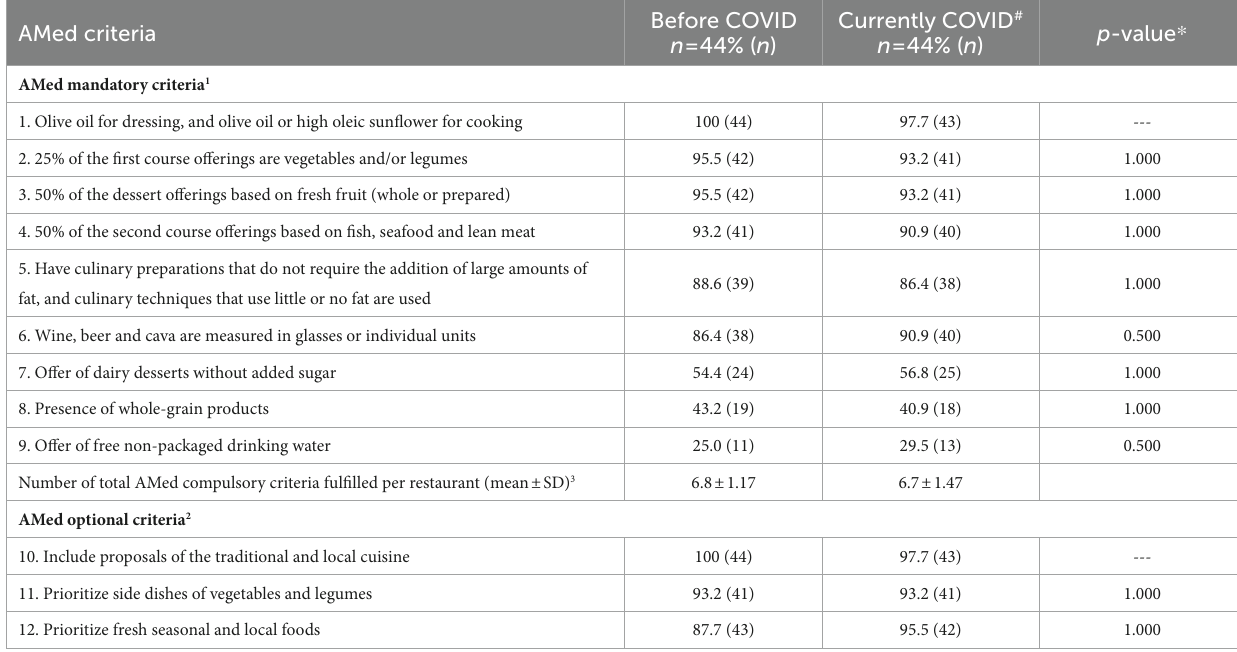
TABLE 2 Mandatory and optional AMed criteria fulfilled by the included restaurants reported by